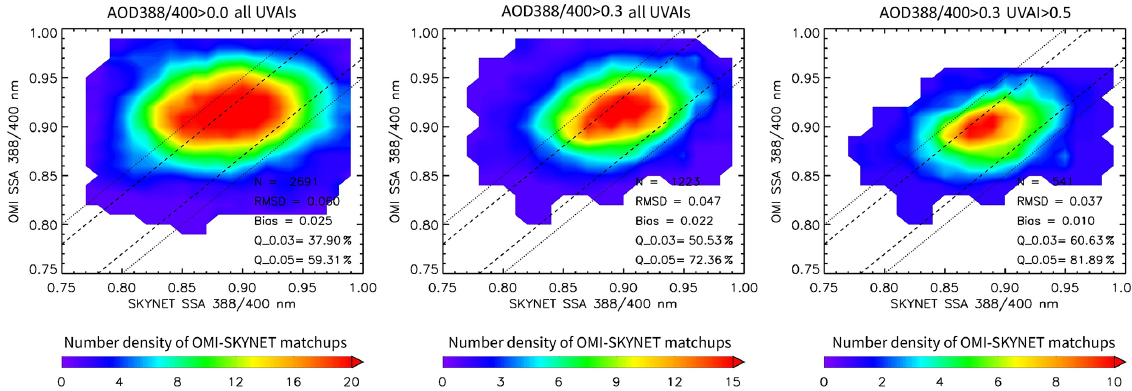
Figure 5. Composite number density plots of the SSA comparison between OMI and SKYNET for different aerosol loading conditions. The resultant statistics of the comparison are depicted in the lower right in each plot. Note that the scale used for the number density of satellite–ground matchups for the three sets of comparisons is different.